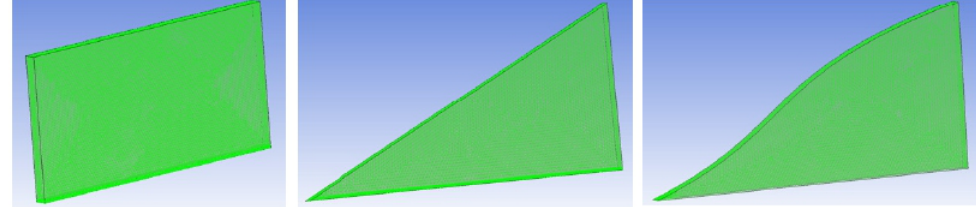
Figure 3. Schematic diagram of the computational domain (not to